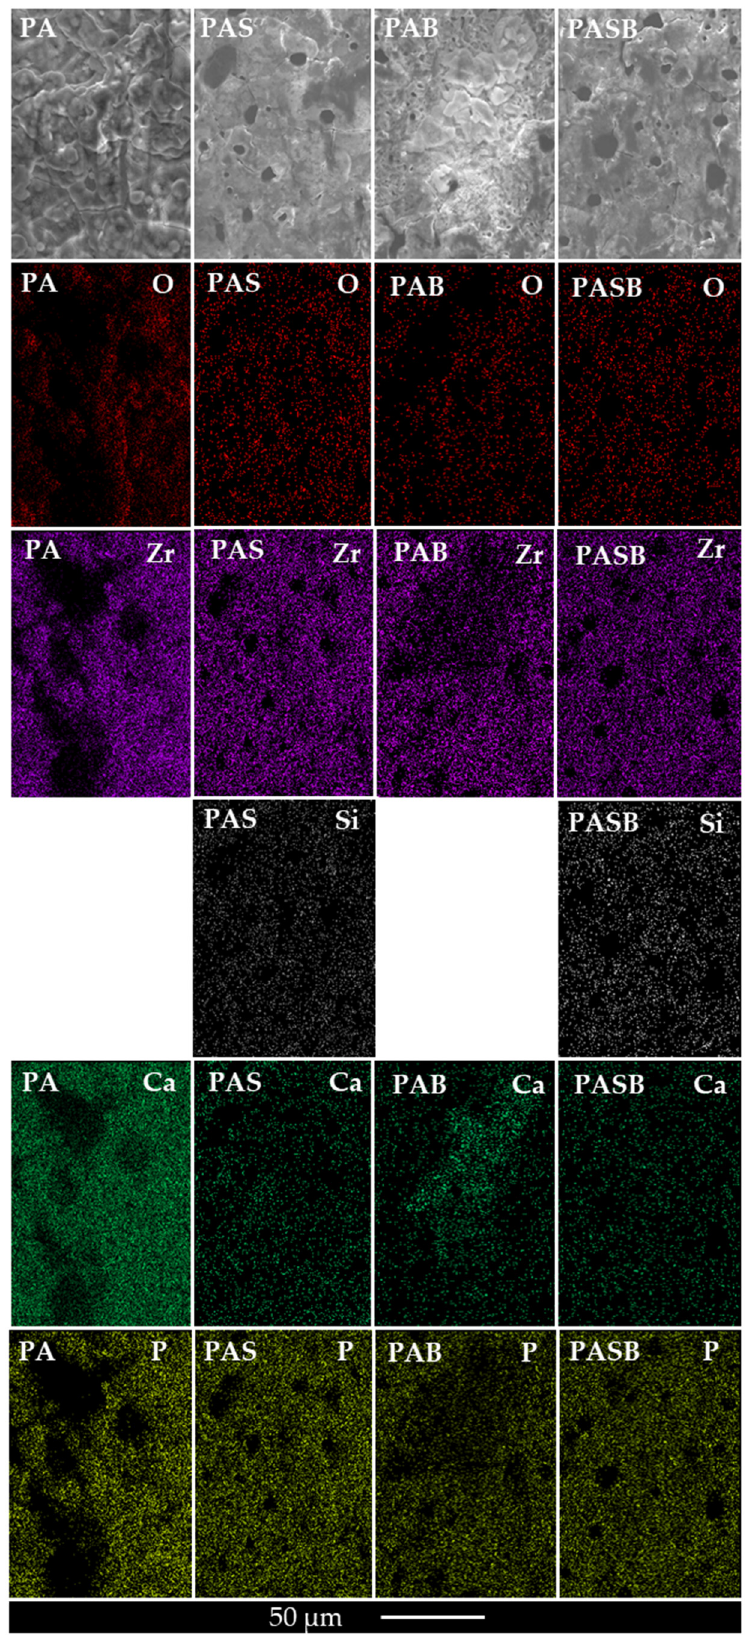
Figure 5. Elemental mapping of the PA, PAS, PAB, PASB-coatings after SBF-test.